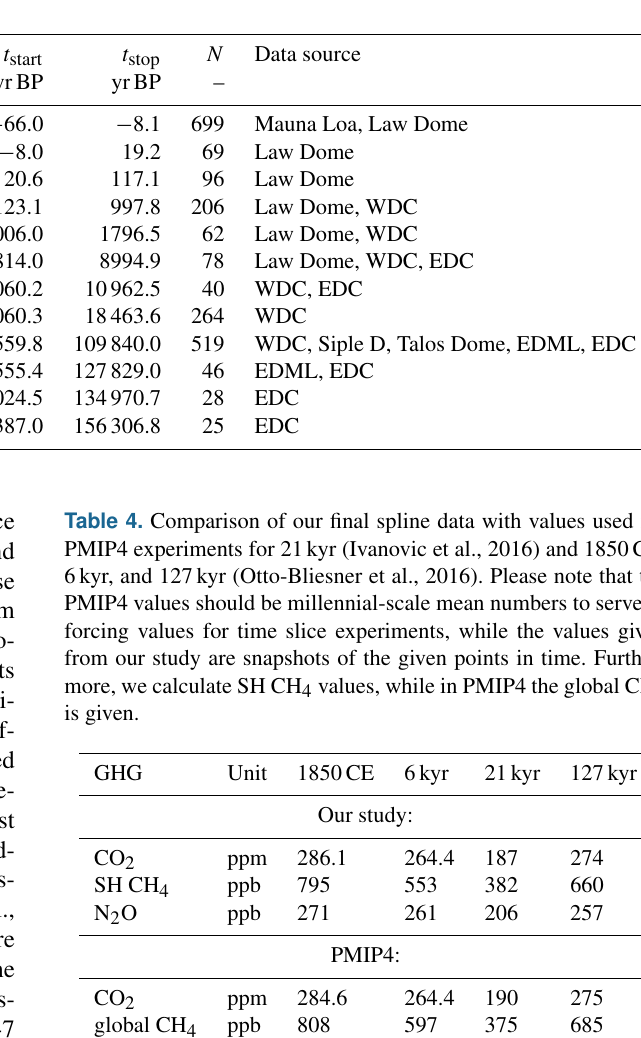
; s : scaling factor to fulfil the constraints given by the prescribed cutoff period P c ; P c : Table 3. Statistics of the CO 2 spline. Interval: i CO 2 average realised cutoff period; (cid:49)t : mean data spacing; v : mean 1 σ error – exact time framing is given by the age of the first ( t start ) and last ( t stop ) data point of the interval (in years BP); N : number of data points within interval. In the last column the underlying data source is briefly mentioned; see Table 2 for details and citations.